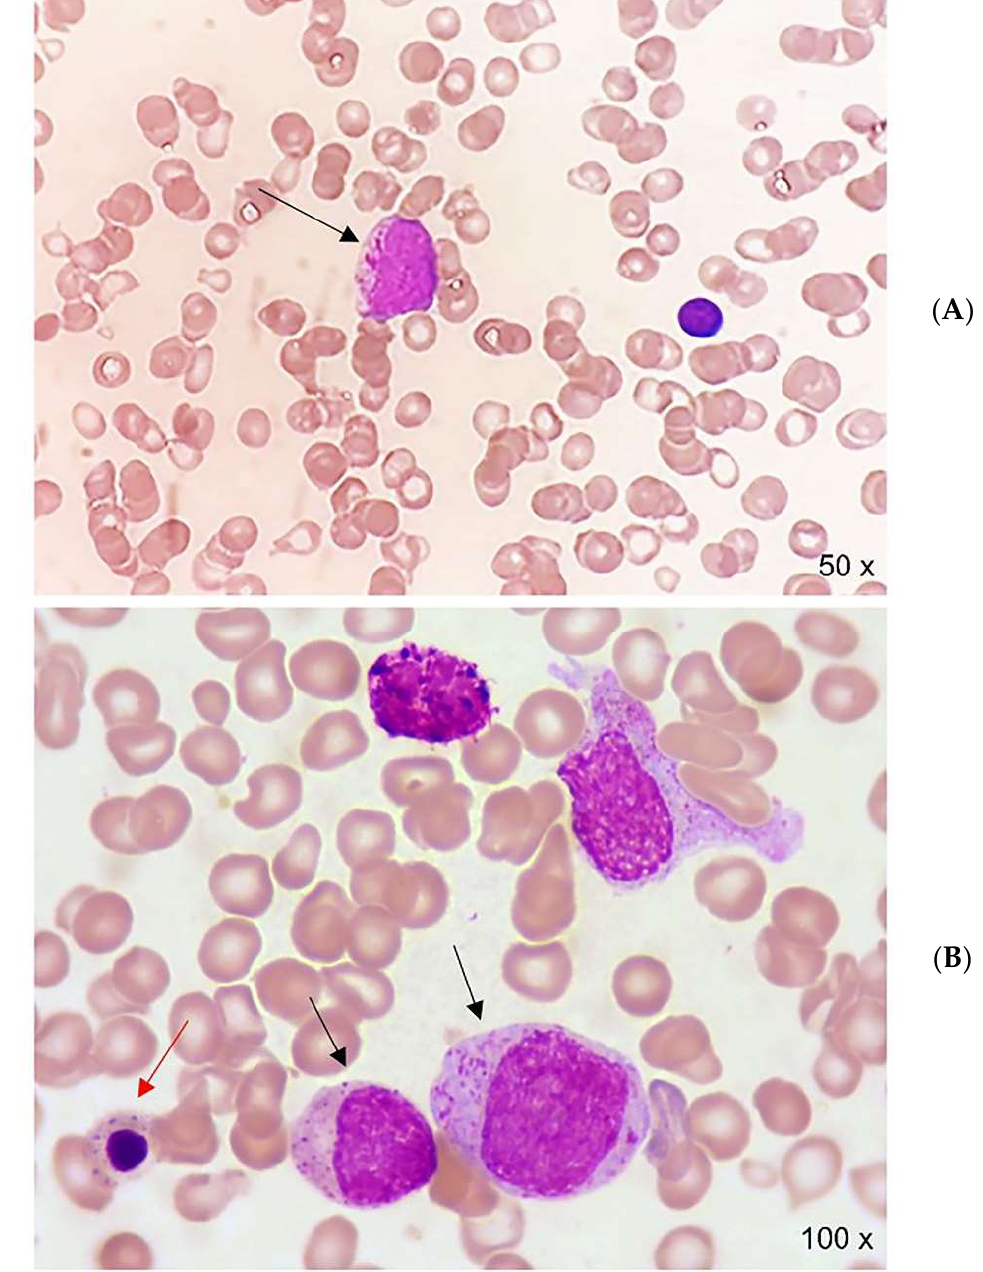
Figure 1. ( A ) Upper picture : peripheral blood smear, showing anisopoikilocytosis, microcytic hypochromic red cells, and numerous target cells. In the center, a leukemic promyelocyte (black arrow). ( B ) Lower picture : bone marrow blood smear, showing promyelocytes (black arrows) and marked dyserythropoiesis (red arrow).